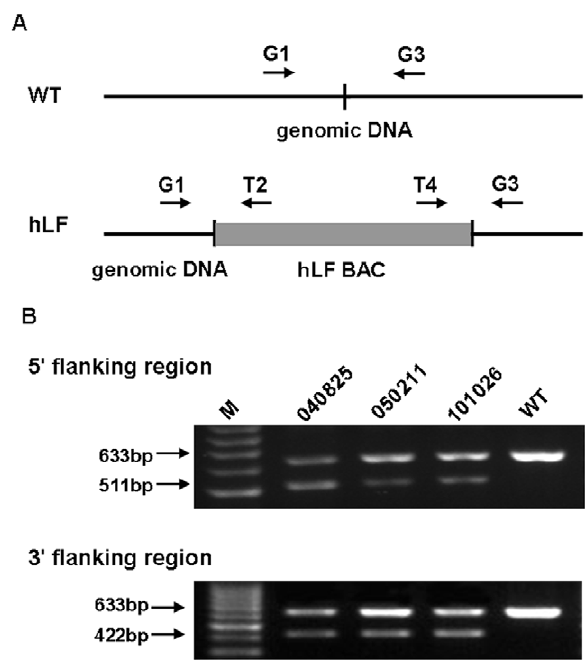
Figure 3. Verification of the integration sites of the transgene by PCR. (A) The arrows represent the PCR primers used for the detection of the flanking sequences. G1 and G3 are genome-specific primers, and T2 and T4 are transgene-specific primers. WT, genome of wild-type cattle; hLF, genome of transgenic cattle. (B) PCR detection of the integration sites in the three transgenic cattle and one wild-type cow. The amplified product for the wild-type sequence was 633 bp, while those for the 5 9 and 3 9 flanking regions of the transgenic sequence were 511 bp and 422 bp, respectively. M, 100 bp DNA ladder; WT, genome of wide-type cattle, which was used as the negative control.